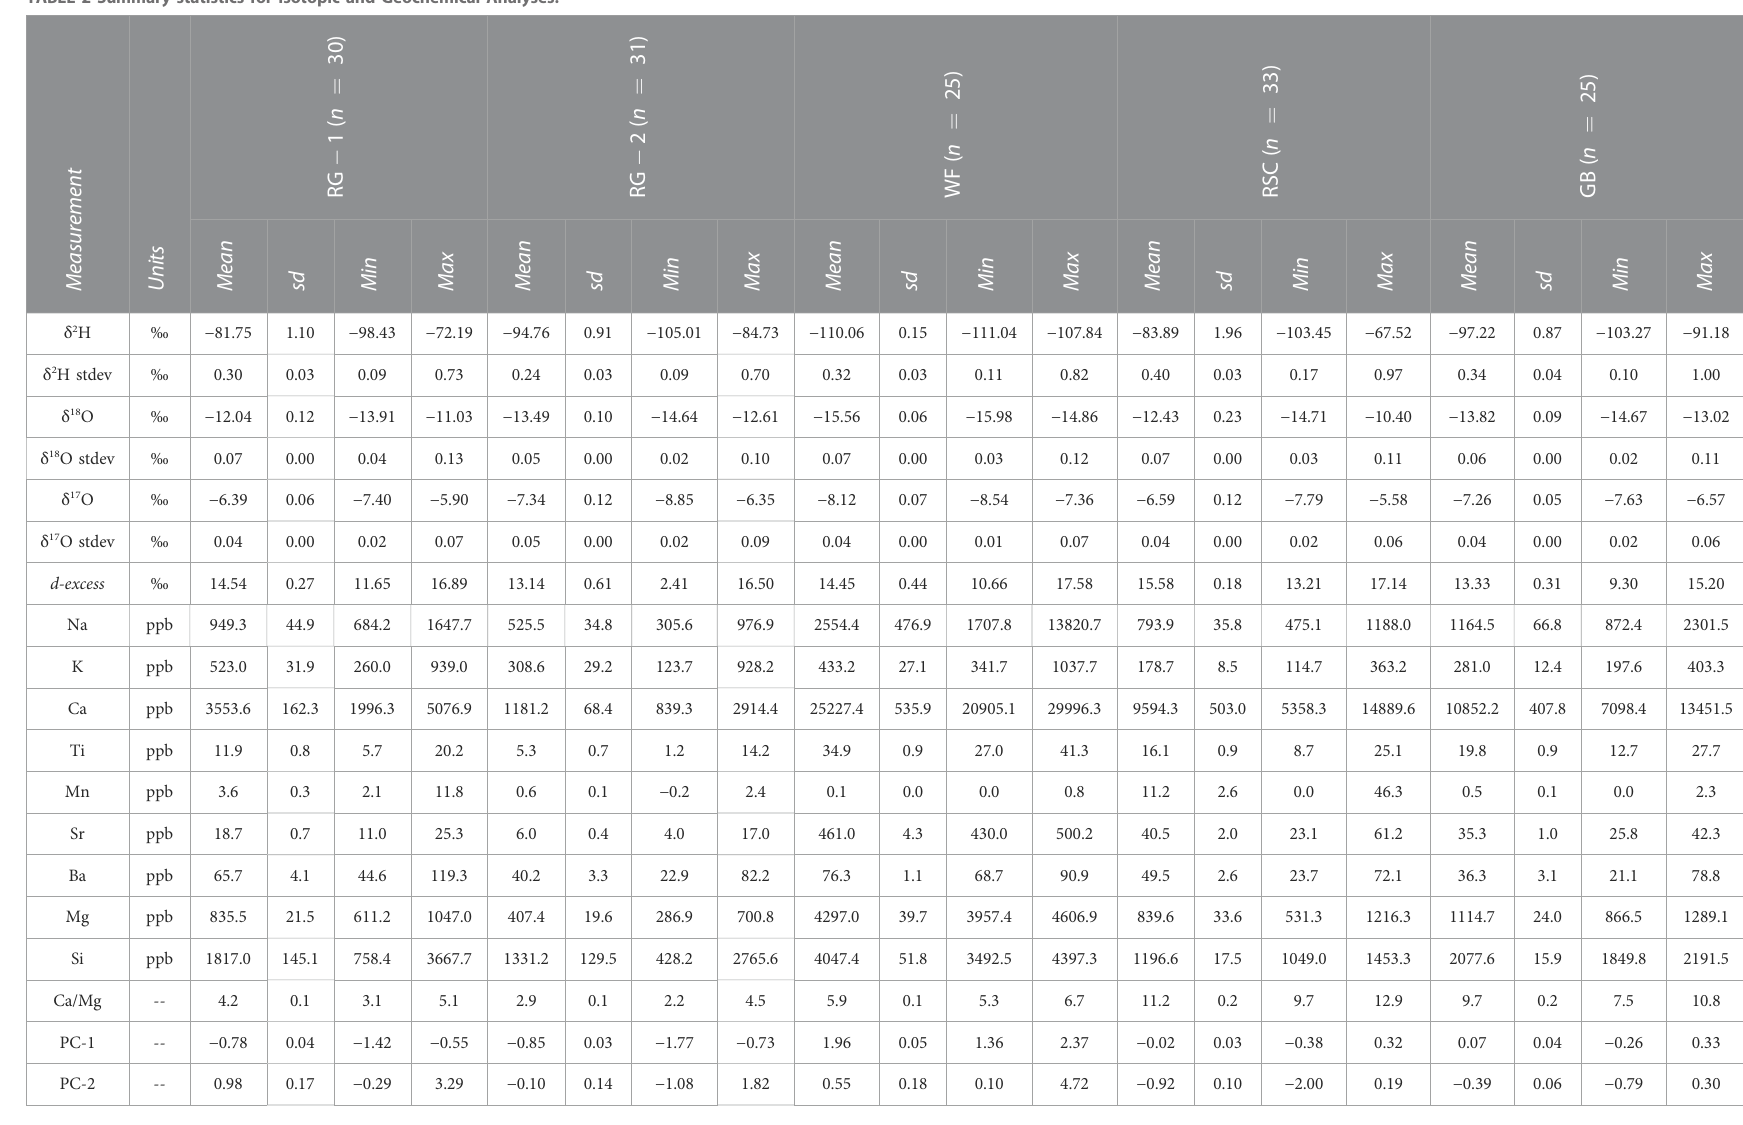
TABLE 2 Summary statistics for Isotopic and Geochemical